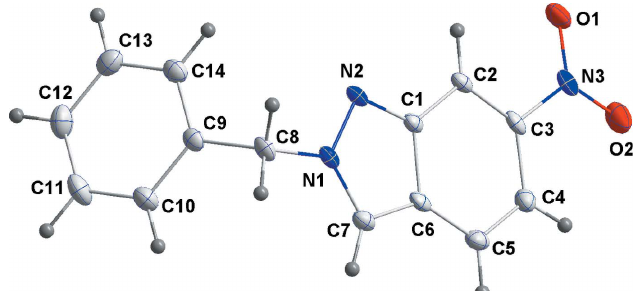
Figure 1 The title molecule, with the atom-labeling scheme and 50% probability displacement ellipsoids.